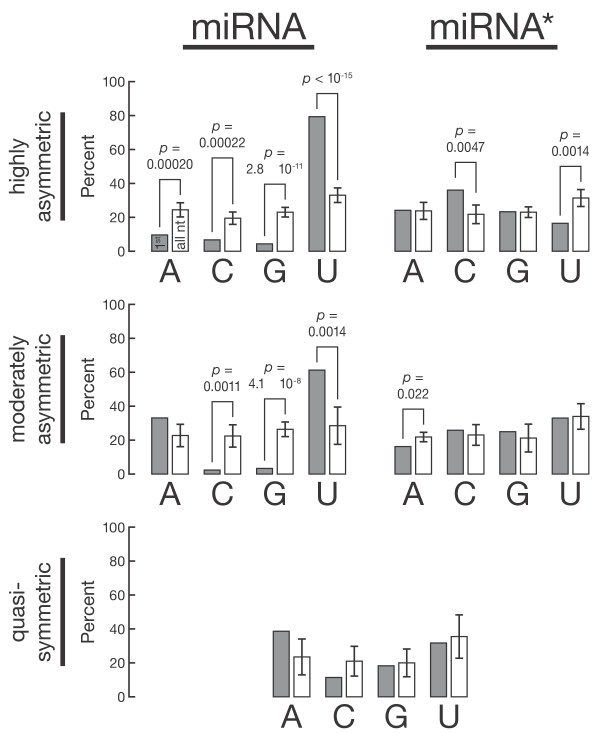
Fly miRNA asymmetry correlates with the identity of the first nucleotide of the small RNA. miRNA/miRNA* duplexes were binned according to their asymmetry: highly asymmetric, miRNA/miRNA* ≥10 in the pooled deep-sequencing libraries; moderately asymmetric, 10 > miRNA/miRNA* ≥ 2; quasisymmetric: miRNA/miRNA* <2; and analyzed as in Figure 1.